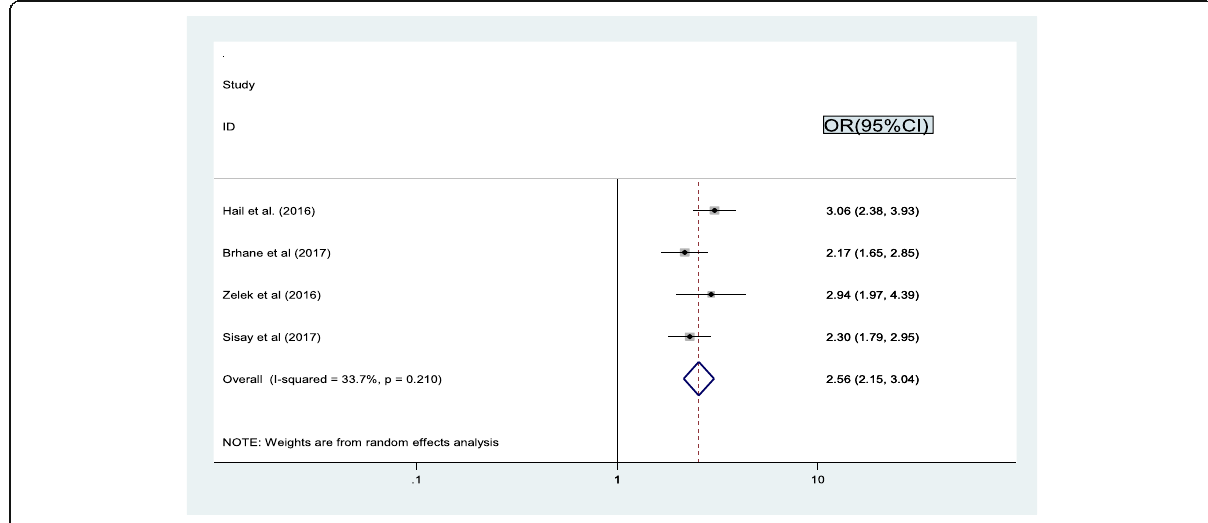
Fig. 4 Pooled odd ratio between co-infection and treatment